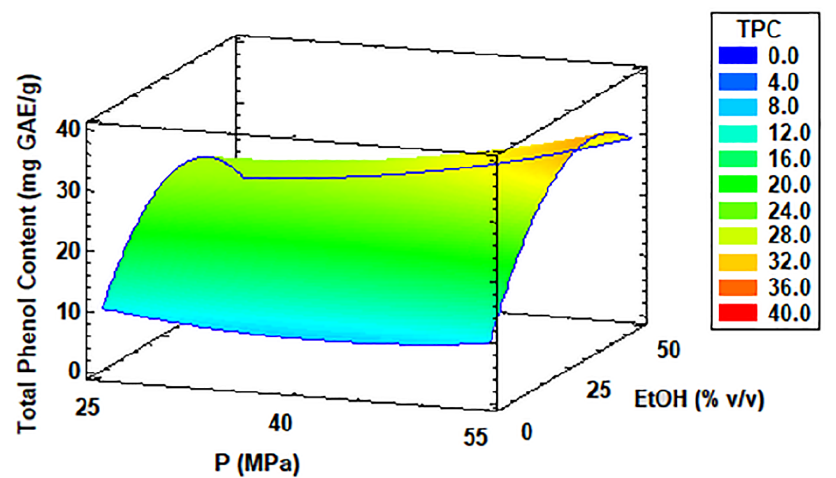
Figure 6. Response surface curve of the combined effects of temperature (30–70 °C), pressure (25–55 MPa), and ethanol as co-solvent (0–50% v / v ) on total phenol content (TPC) from Coccomyxa onubensis. Response surface curves were drawn from the viewpoint of the optimal temperature (70 °C). Abbreviation: temperature (T), pressure (P), and ethanol as co-solvent (EtOH).